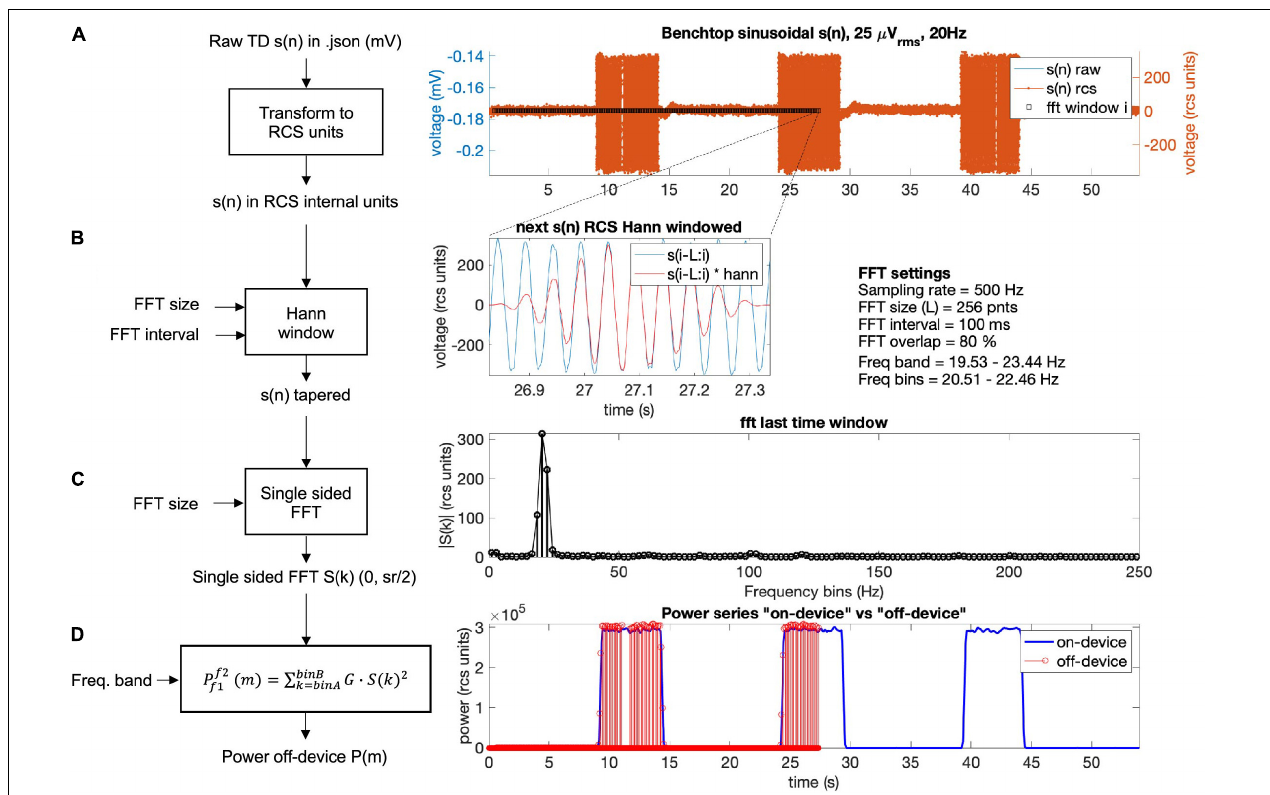
FIGURE 9 | Power calculation off-device replicating the on-device power calculation for a benchtop dataset with three 5 s bursts of a 25 microvolts sine wave at 20 Hz frequency. The calculation is conducted following four steps: (A) The raw time domain neural signal s (n) (mV) is transformed back to internal device units, RCS units (see Equation 1, Table 5 ). (B) To minimize spectral leakage, a Hann window is applied to each new analysis window of the transformed signal s (n). The new analysis window ( ∼ 26.9–27.3 s) is defined by the size and interval of the FFT (Equations 2, 3). The raw signal within the next time segment is shown in blue and the Hann window tapered signal is in red. (C) A single-sided FFT is applied to the Hann tapered signal s (n) resulting in an amplitude FFT value per each frequency bin of the complete FFT band (0 to 1 / 2 sampling rate). For the exact scaling of the single sided FFT see function “calculateNewPower” (scaling steps 1 and 2) on https://github.com/openmind-consortium/Analysis-rcs-data. (D) Power is computed as the sum of squares of each FFT amplitude multiplied by a gain factor G (scaling step 3) for all frequency bins within the frequency band. The on-device power series is shown in blue and the off-device calculated power, up to the last analyzed window in this graph ( ∼ 27 s) is depicted in red (using the matlab function stem). The time alignment between the on-device and the off-device signal is accurate as the perfect overlay between sample points at the power signal flanks shows.